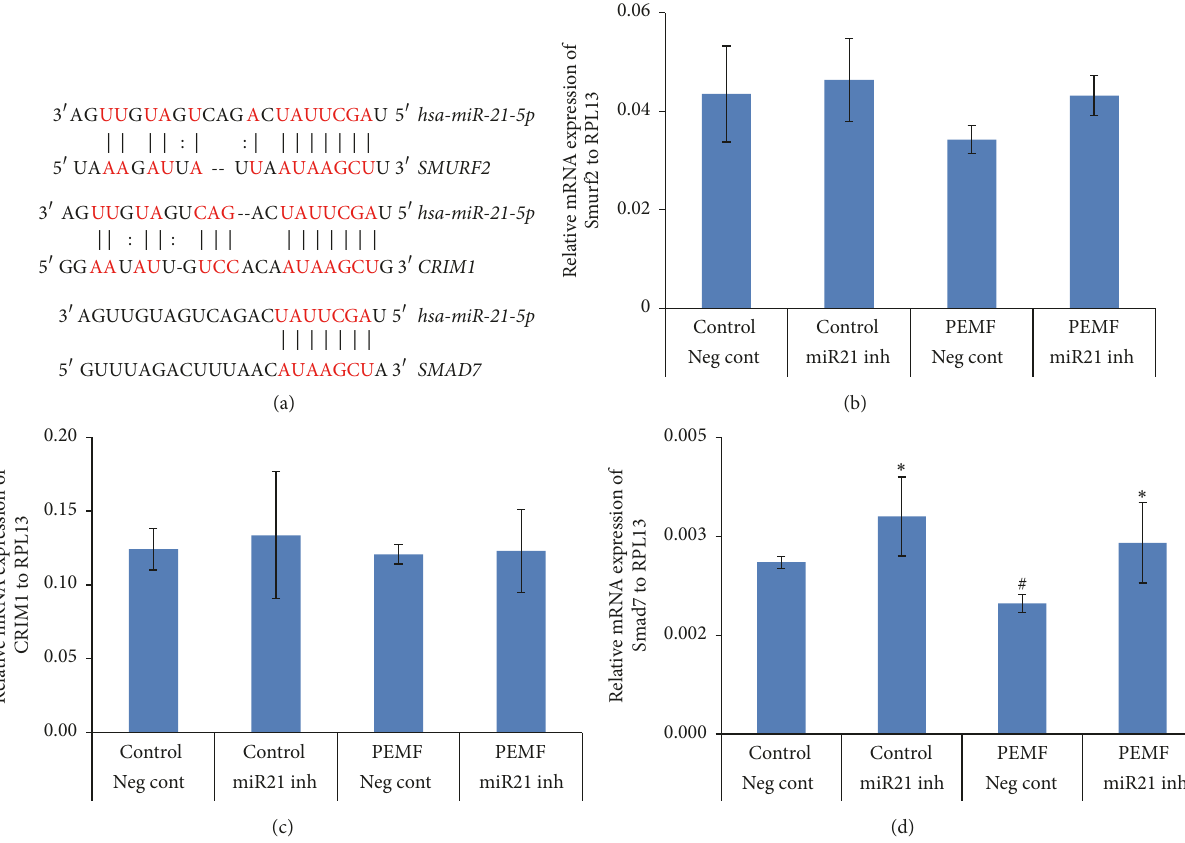
Figure 8: Putative target genes of miR21-5p and PEMF decreases Smad7 mRNA through miR21-5p. (a) The putative target region analysis was performed for Smurf2, Crim1, and Smad7 mRNAs 3 󸀠 UTR by miR21-5p seed sequence. ((b)–(d)) Human BMSCs from a 27-year-old female were transiently transfected with 50nM of negative control miRNA or miR21-5p inhibitor for 72 h in osteogenic medium and PEMF treatment wascarriedoutconcurrentlyfor4 heachdayfor3days.TotalRNAwasisolatedandRT-qPCRwascarriedoutusingtheprimersfor(a)Smurf2, (b) Crim1, and (c) Smad7 genes. Expression of mRNAs is shown relative to that of the RPL13 gene. 𝑛 = 3 . ∗ indicates significant increase compared to negative control miRNA transfection or PEMF treatment with negative control miRNA transfection. # indicates significant decrease compared to PEMF treatment with miR21-5p inhibitor transfection. Analysis by one-way